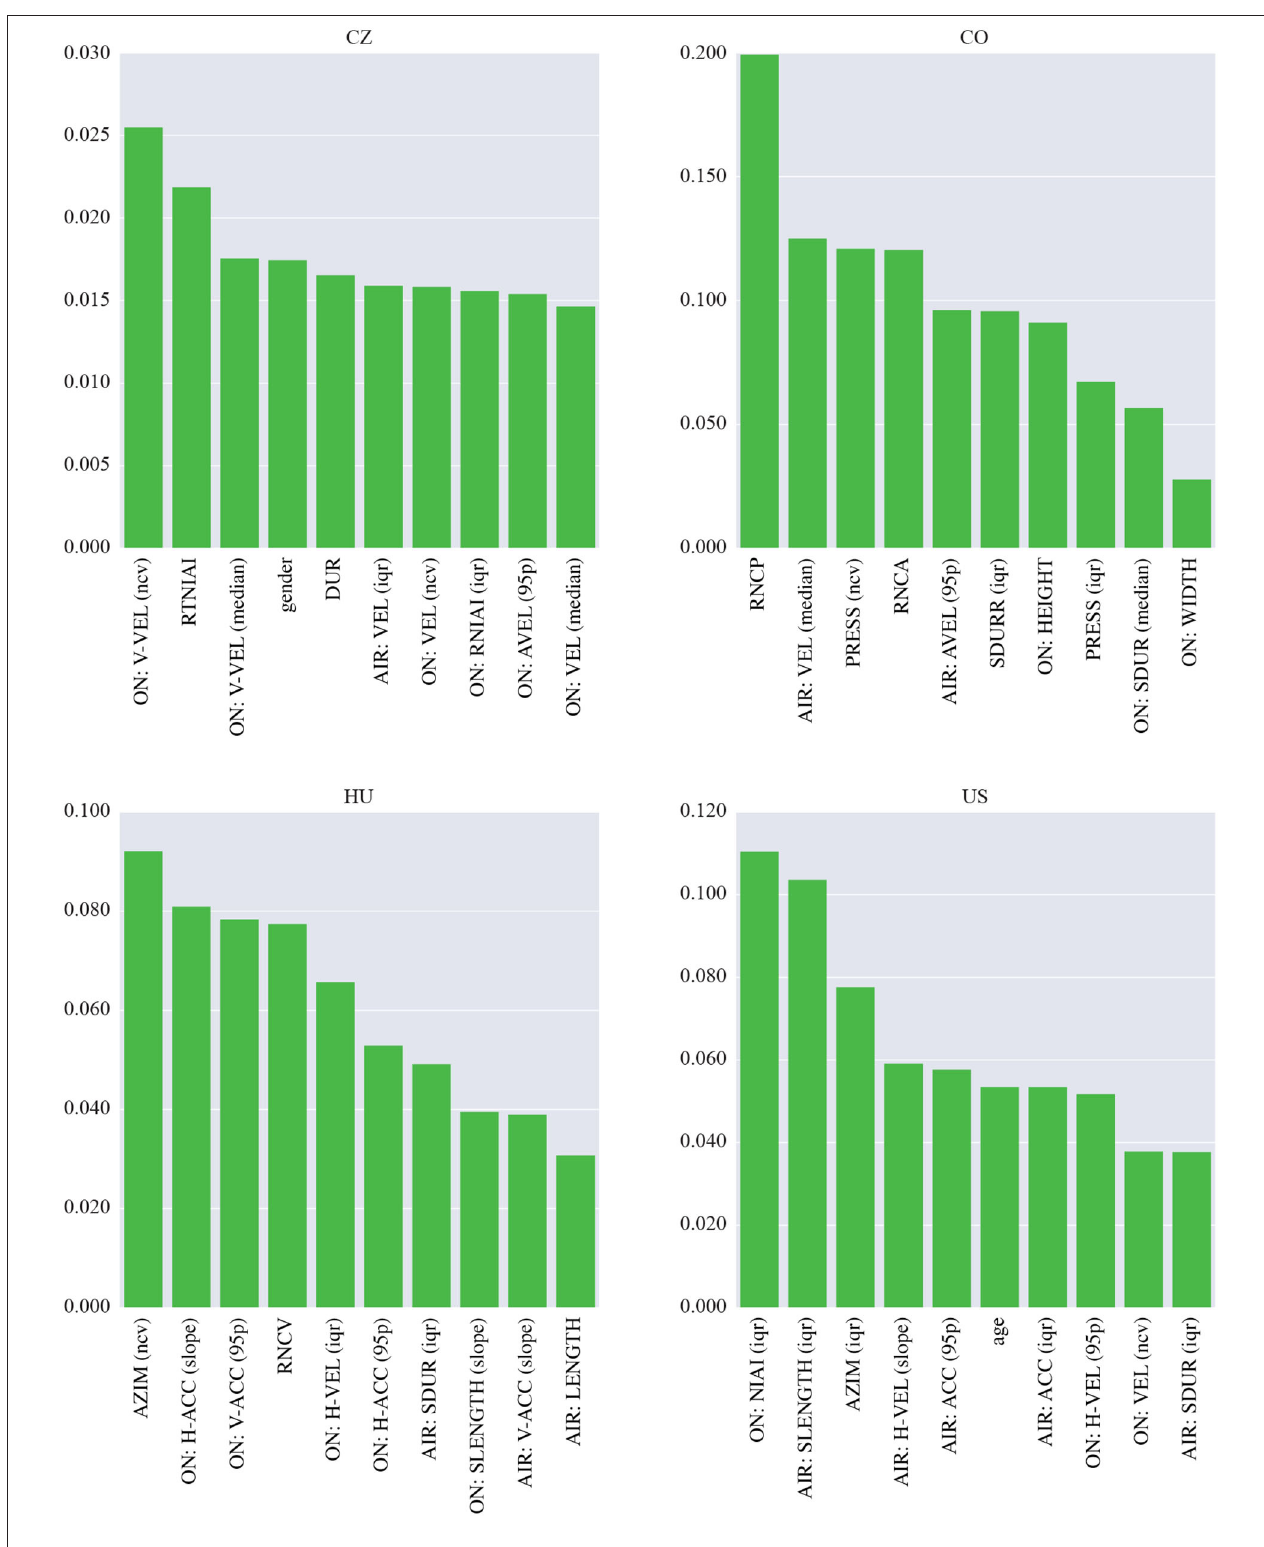
FIGURE 3 | Importance of the features used in the models in the single-language scenario (sentence writing task).